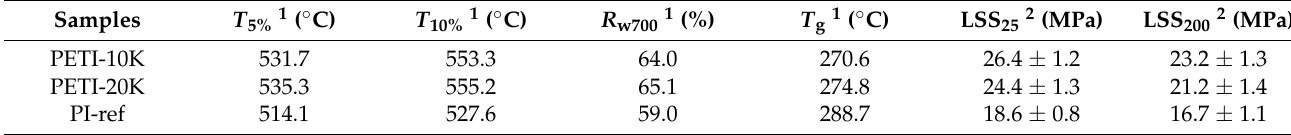
Table 2. Thermal and adhesion properties of the electrospun PI nano-fibrous membranes. Samples